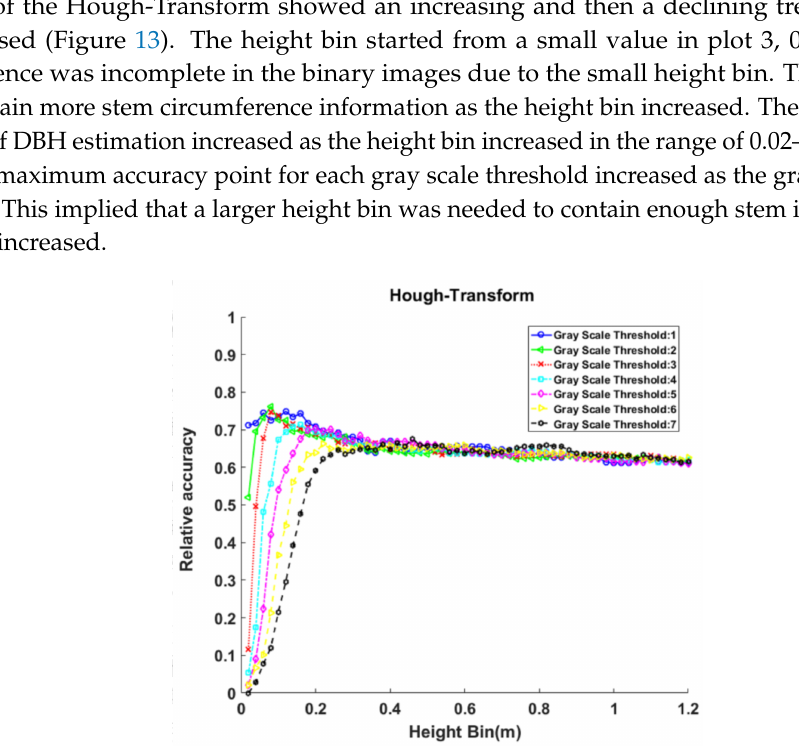
Figure 13. The relative accuracy of Hough-Transform under different height bins and gray scale thresholds in single-scan mode of the